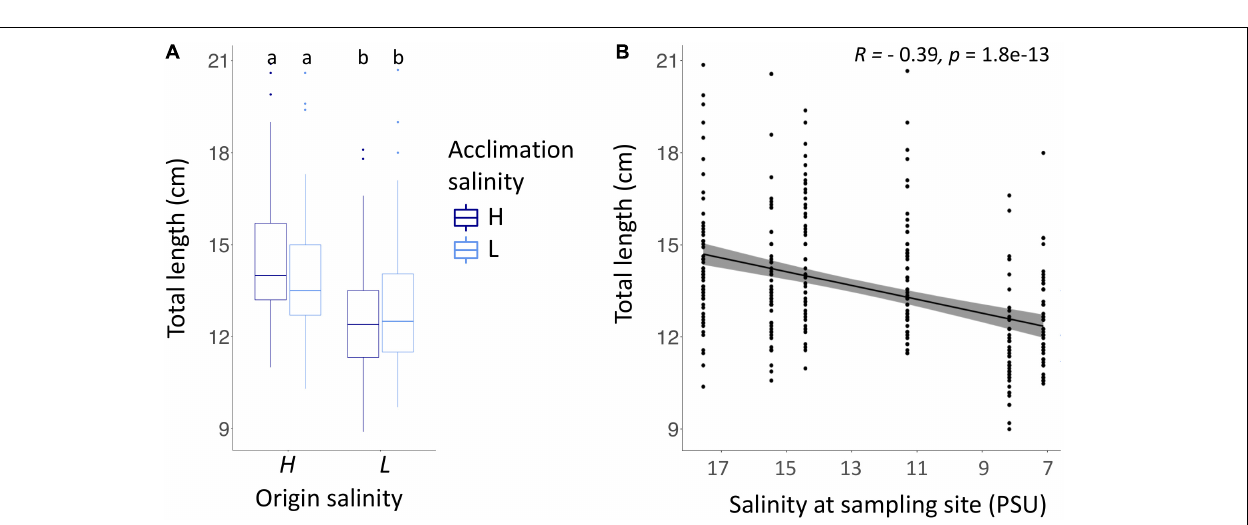
Brood Size Males from a high origin salinity kept at high acclimation